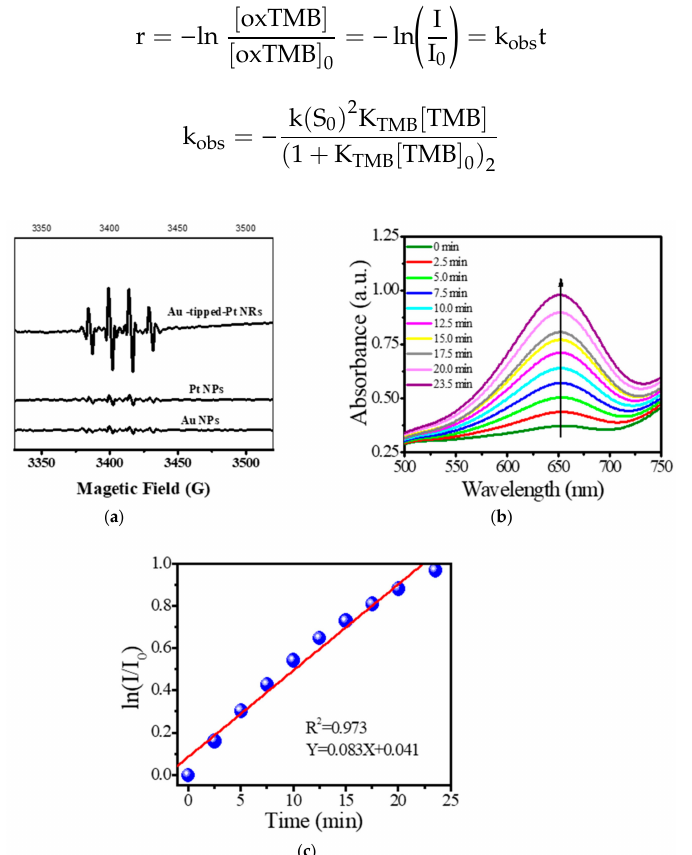
Figure 3. ( a ) The spin-trapping spectra of Au NRs, Pt NPs and Au@Pt NRs; ( b ) time-dependent accelerating e ff ect of Au-tipped Pt NRs catalyzed TMB; ( c ) Lineweaver-Burk plots of Au-tipped Pt